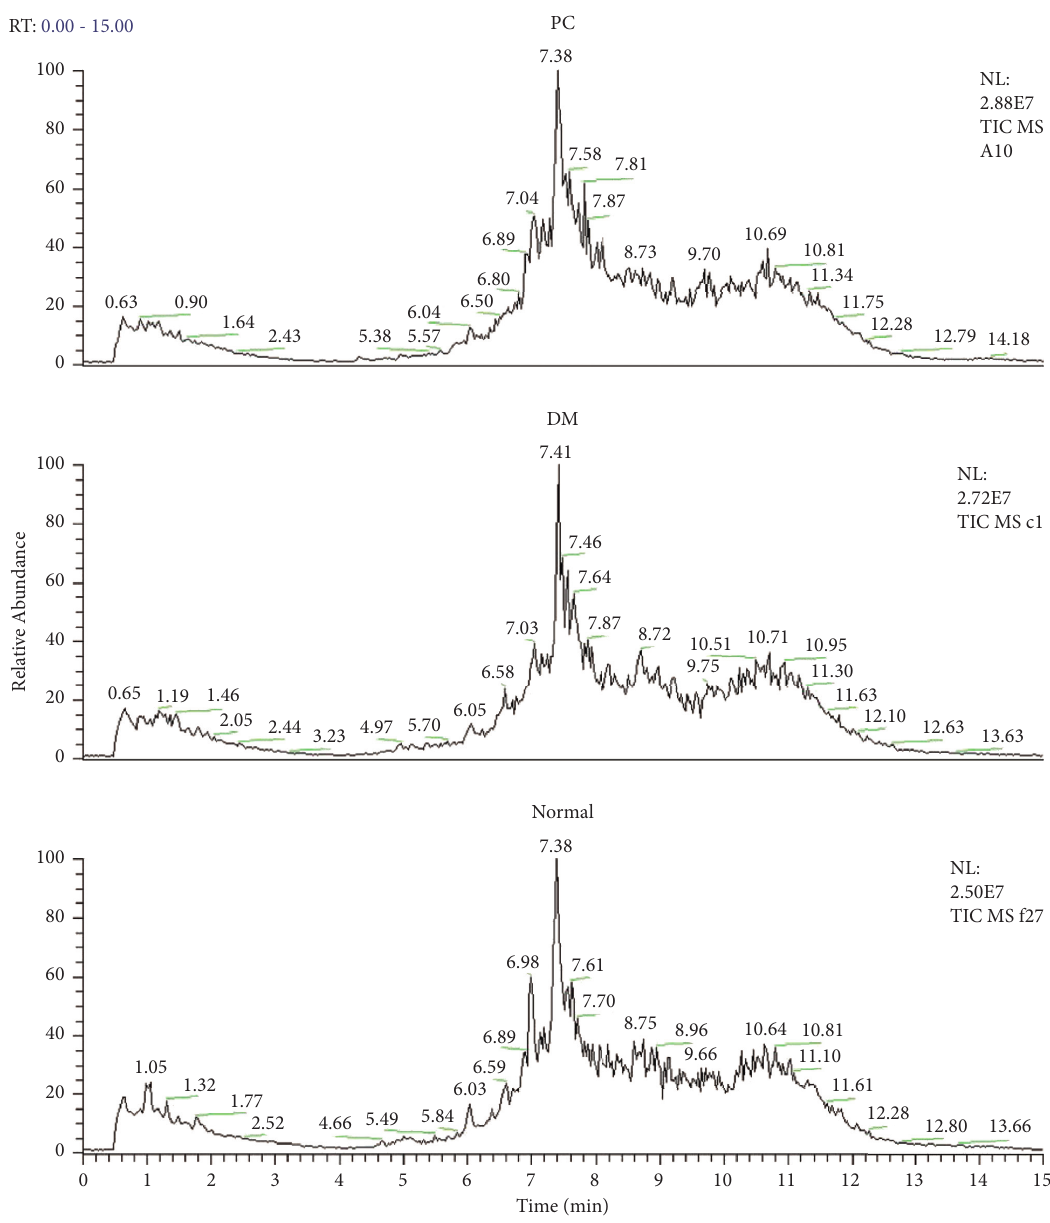
Figure 1: Total ion chromatogram (TIC) of plasma samples from pancreatic cancer (PC), diabetics (DM), and healthy controls (normal), indicating the PC- and DM-caused variation in the content of small molecule